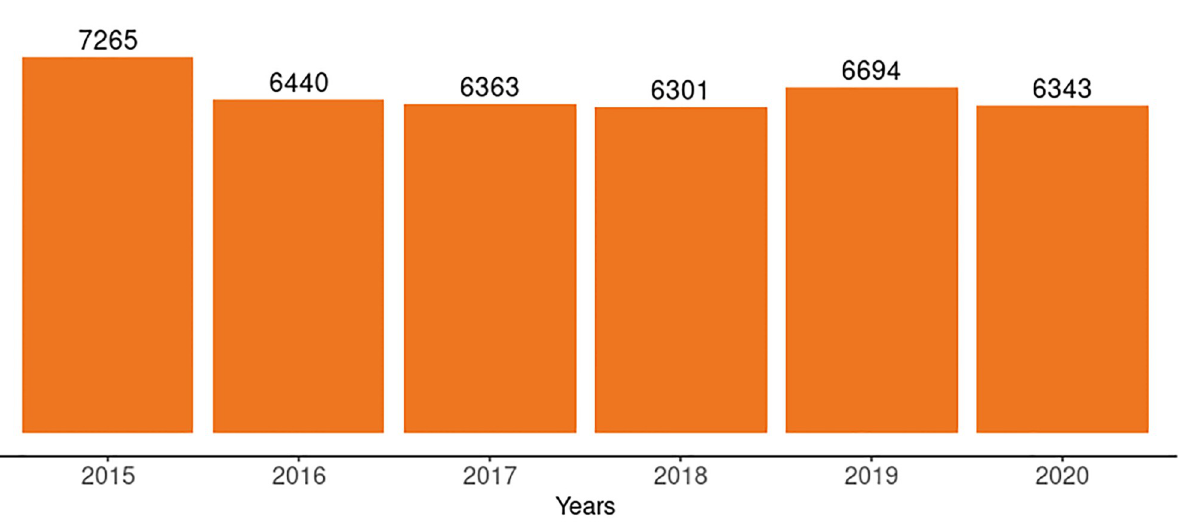
Fig 3. Number of health facilities that provided PMTCT services from 2015–2020.